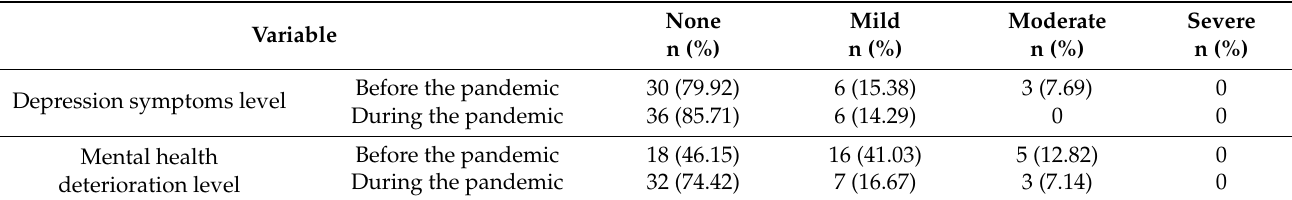
Table 4. Prevalence of depression symptoms and mental health deterioration levels.